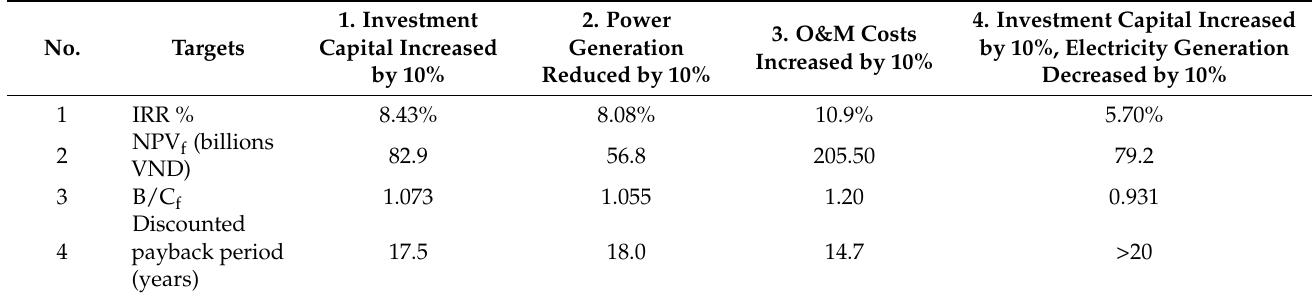
Table 8. Sensitivity analysis results.